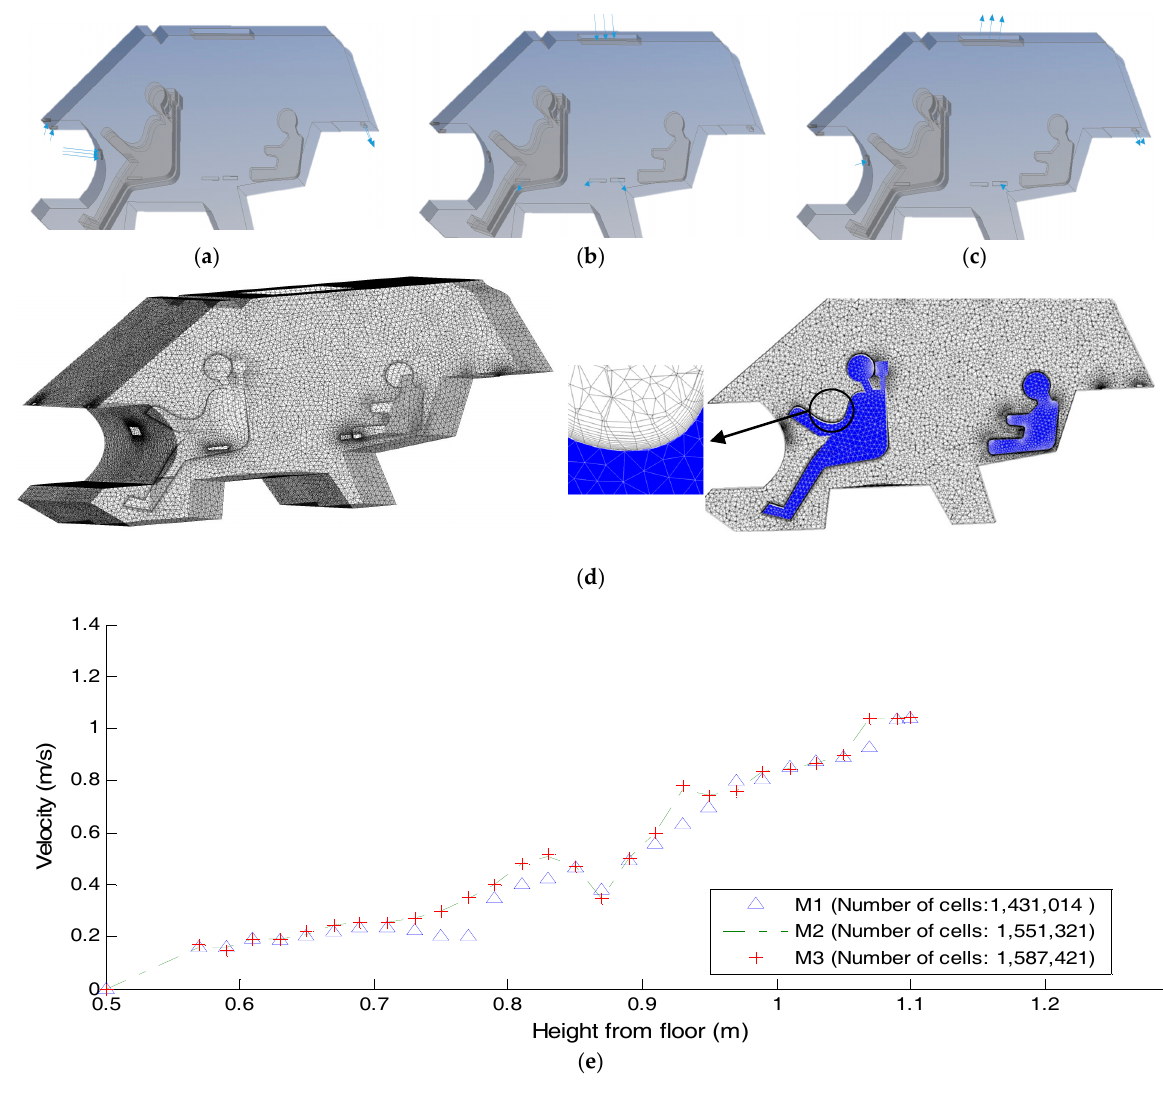
Figure 1. Sketches of investigated ventilation cases with ( a ) front inlets, ( b ) trickle inlet ceiling, and ( c ) side inlets ( d ) Mesh domain ( e ) Grid independence test for velocity near driver’s section